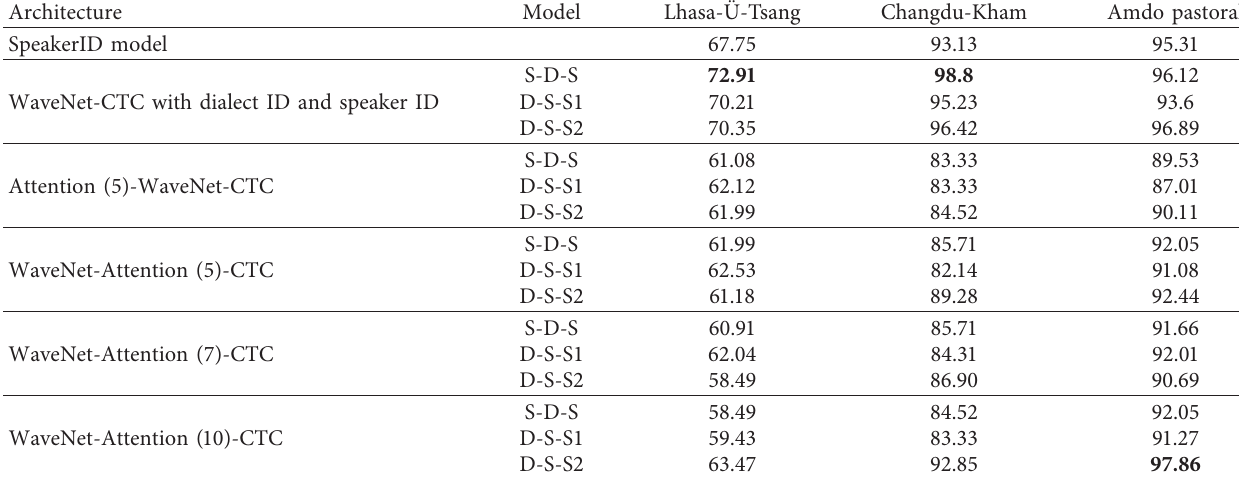
Table 7: Speaker ID recognition accuracy (%) of three-task models. Architecture